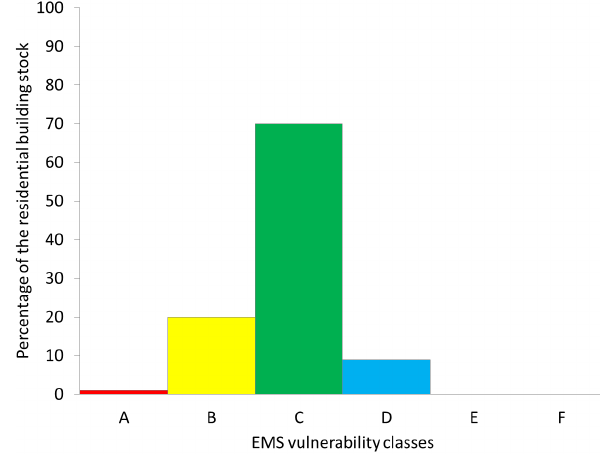
Figure 4. Vulnerability composition model of the residential building stock of Cologne as a percentage of the different vulnerability classes of EMS-98 (based on the INFAS database, 2010).